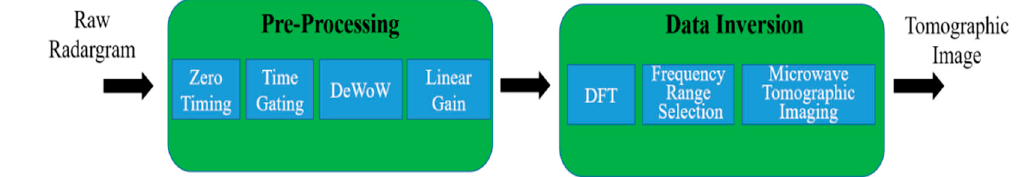
Figure 3. The advanced data processing based on microwave tomography.